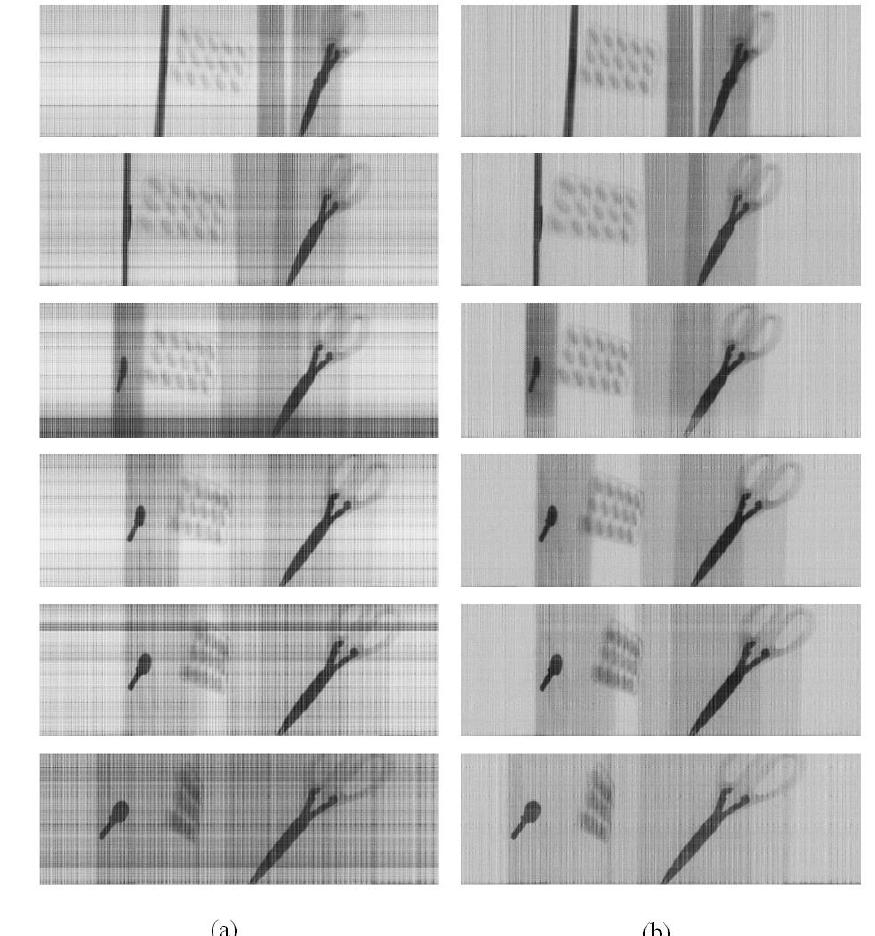
Figure 2. (a) shows an example of six out of the twelve projection images produced of a phantom built. This phantom contains three vertical acrylic sheets, a metal key, a pair of scissors and a sheet of off counter pills. (b) shows the same six projections after after noise reduction methods developed have been